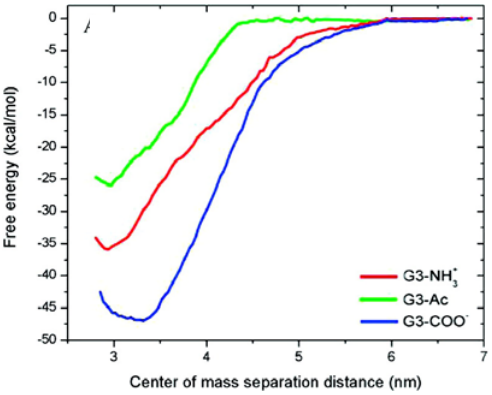
Figure 2 . Potential of mean forces for G3 PAMAM dendrimers interacting with different surface charges as a function of center-of-mass separation distance between the dendrimer and lipid bilayer (energy per mole binding to the bilayers). Reprinted with permission from [26]. Copyright 2008 American Chemical